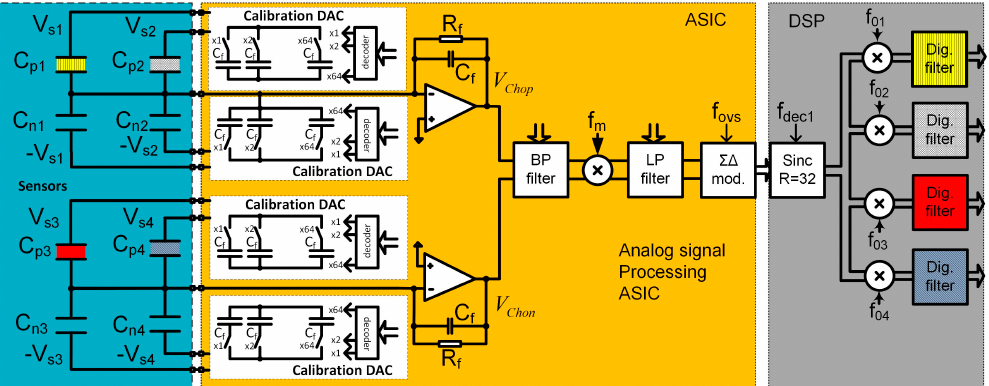
Figure 8. Block diagram of one channel of the detection system. It is composed of the blue region with maximum of 4 differential sensors (different colour represent different modification), the ASIC in yellow region which contains analogue signal processing electronics together with calibration DACs (in white regions), and on the right, in the grey area, the DSP part of the signal processing electronics of one channel.